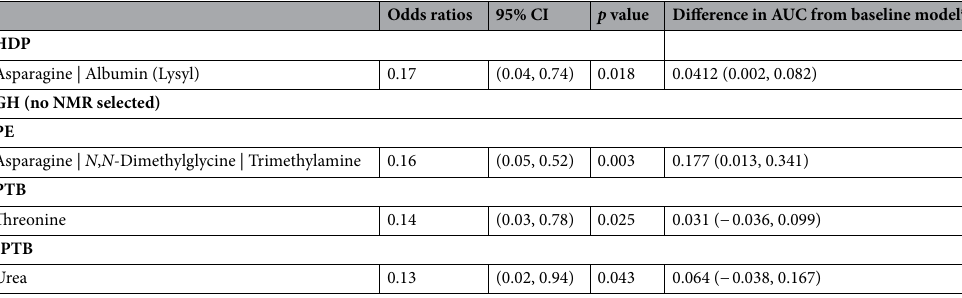
Table 3. NMR metabolites associated with HDP and PTB in cross-validated multiple logistic regression model (NMR). Adjustment factors: HDP: BMI at first prenatal care visit, illegal drug use in the year before pregnancy, gravidity; GH: BMI at first prenatal care visit, illegal drug use in the year before pregnancy, gravidity; PE: illegal drug use in the year before pregnancy, gravidity; PTB: obesity, and illegal drug use in the year before pregnancy, gravidity; sPTB: gravidity. HDP, any hypertensive disorder of pregnancy; GH, gestational hypertension; PE, pre-eclampsia, PTB, preterm birth; sPTB, spontaneous preterm birth; GDM, gestational diabetes mellitus. a Baseline model includes only adjustment